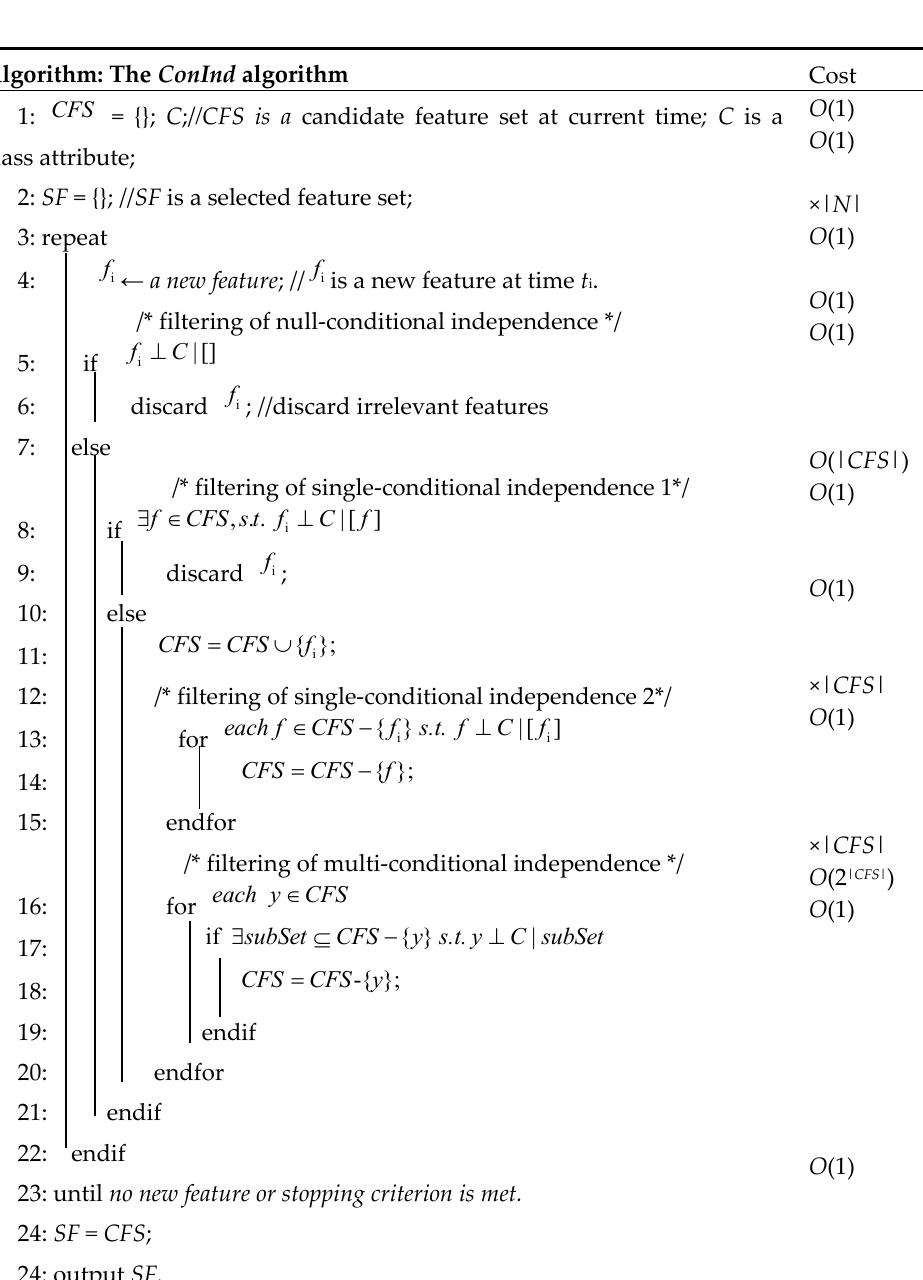
Figure 6. The ConInd algorithm.